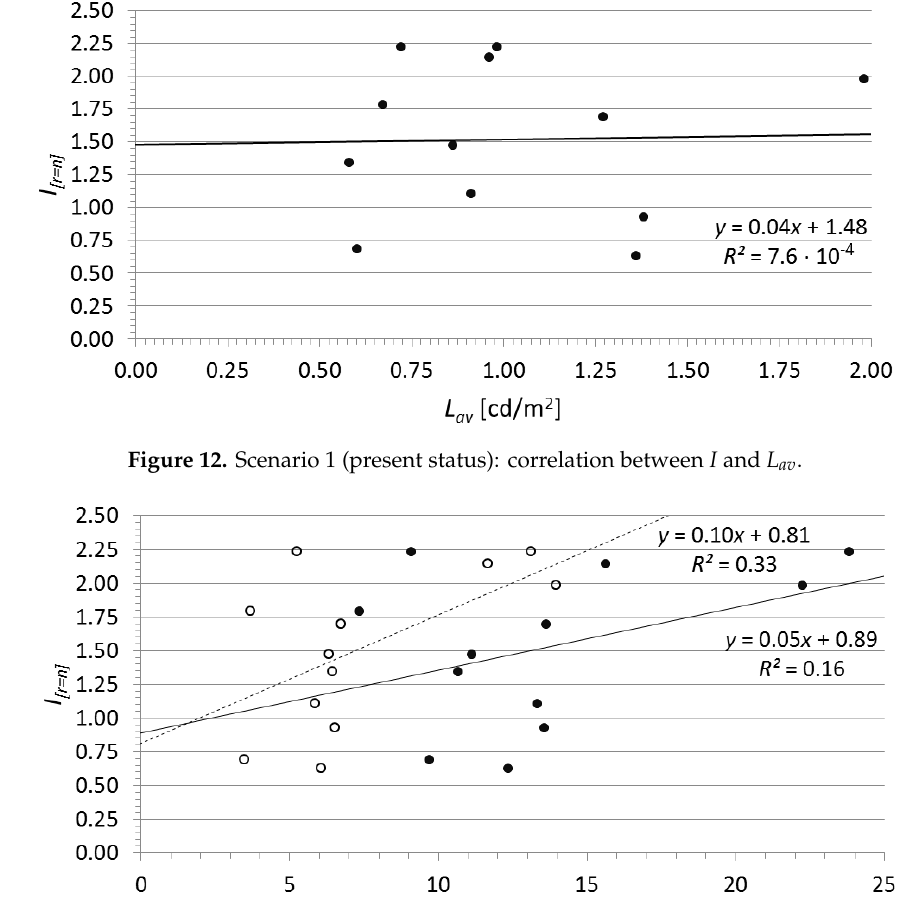
Figure 14. Scenario 1 (present status): correlations between I and E h,av (black circles and a continuous line for the regression) and between I and E h,min (white circles and a dotted line for the regression) on the sidewalks on the opposite side of the luminaires. 4.2. Correlations in the Case of Scenario 2 (Design Status) In Figure 15, the correlation between the I index and L av at the design status (see Section 3.3) is shown. In this case, compared to the present status (see Figure 12), R 2 increases from a negligible value to 0.63. The regression line slope is positive suggesting that as roads centrality increases, luminance levels increase because more trafficked roads need to be more enlightened. The R 2 coefficients increase also for the correlations between I index and both E h,av and E h,min . Looking at the sidewalks on the same side of luminaires (see Figure 16), for E h,av , R 2 varies from 0.16 (see Figure 13) to 0.48; while for E h,min , R 2 varies from 0.33 (see Figure 13) to 0.39. The slopes of the regression lines are positive so for more central roads the illuminance levels increase. Looking at the sidewalks on the opposite side of luminaires (see Figure 17), it can be observe that, for E h,av , R 2 varies from 0.08 (see Figure 14) to 0.43; while for E h,min , R 2 varies from a negligible value (see Figure 14) to 0.41. The slope of the regression lines is positive so for more central roads the illuminance levels increase.